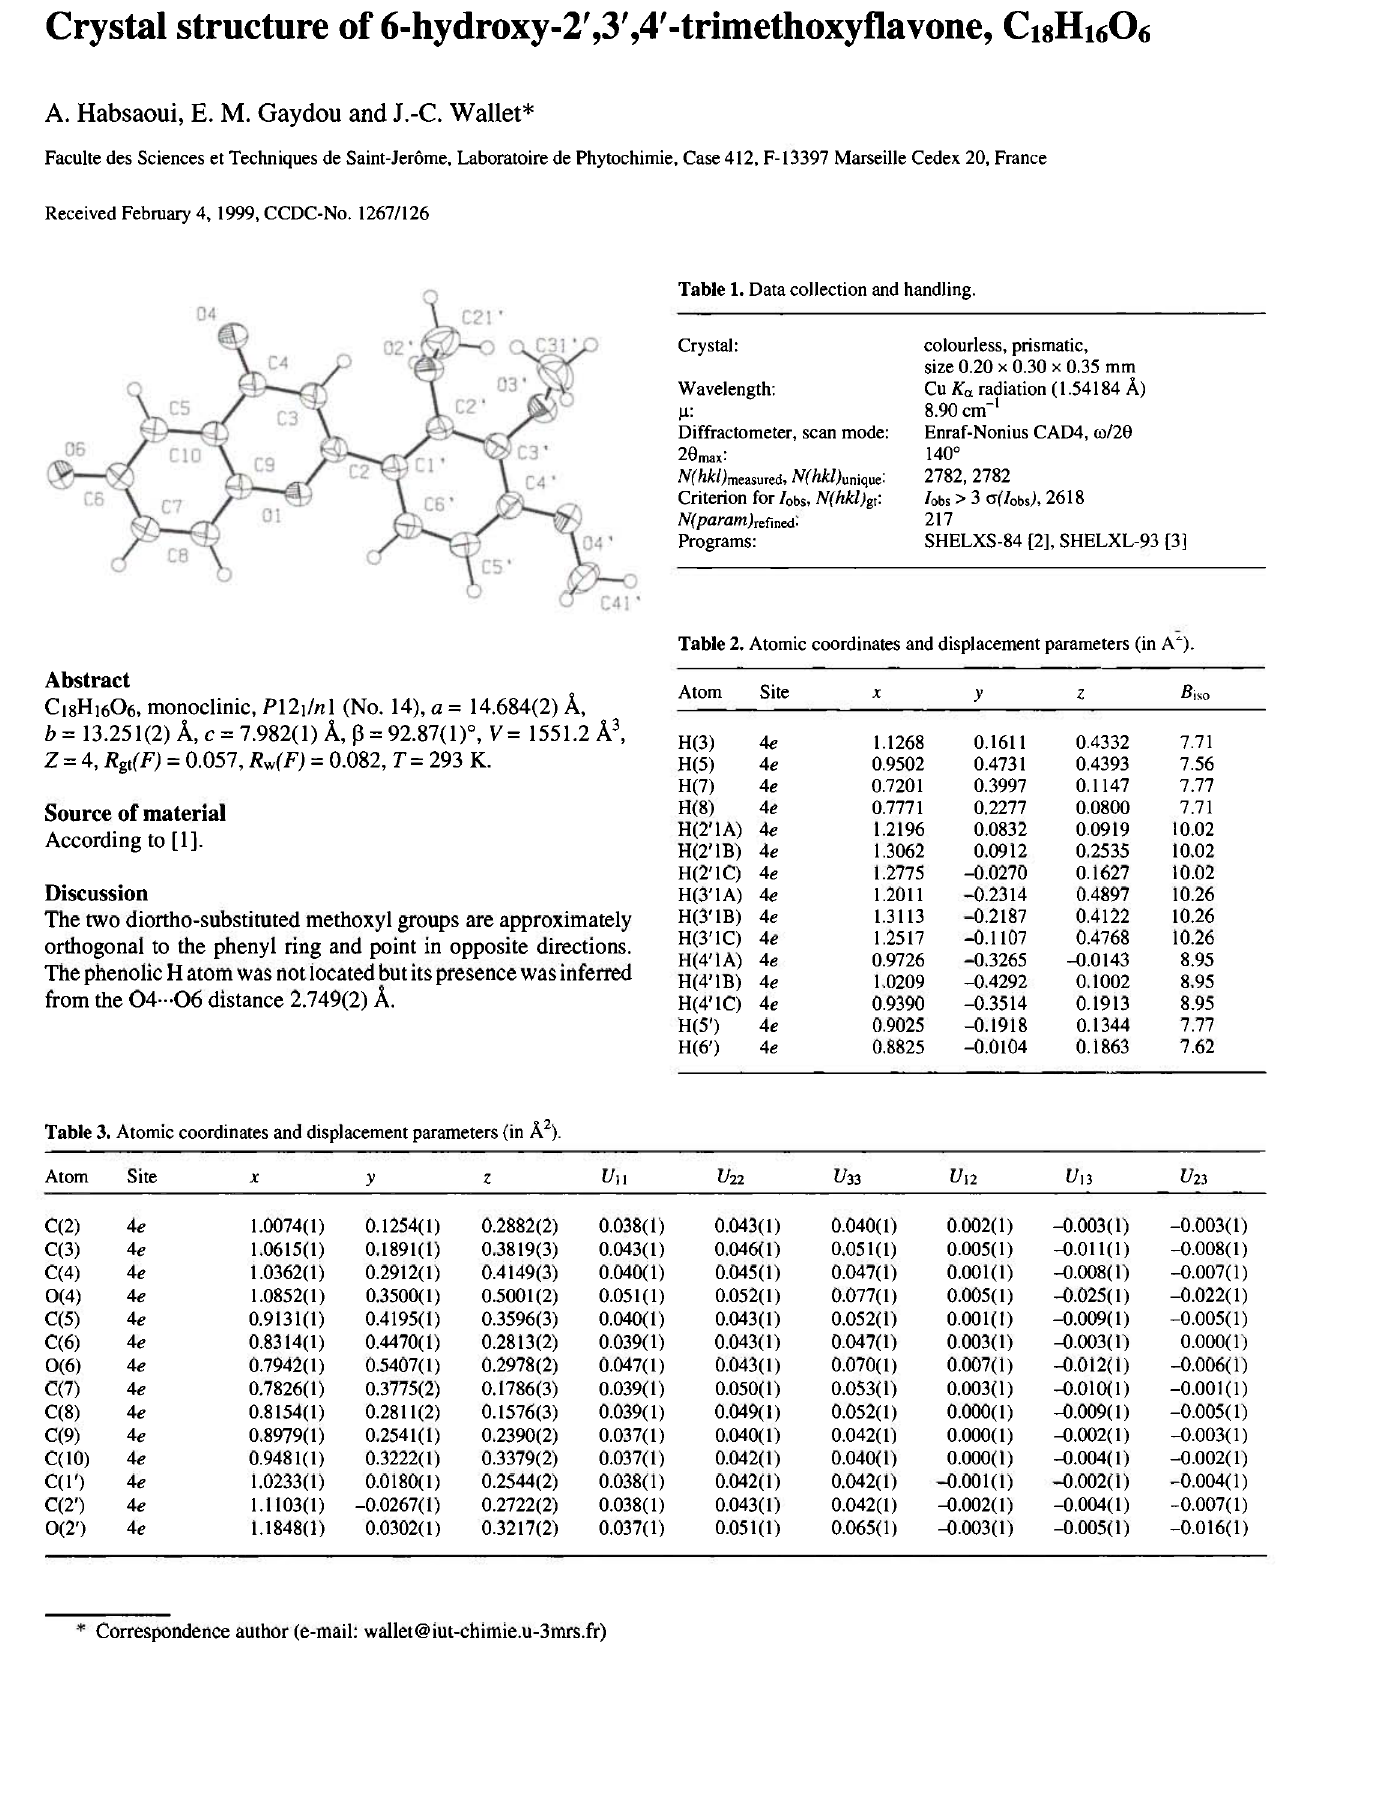
Table 1. Data collection and handling.